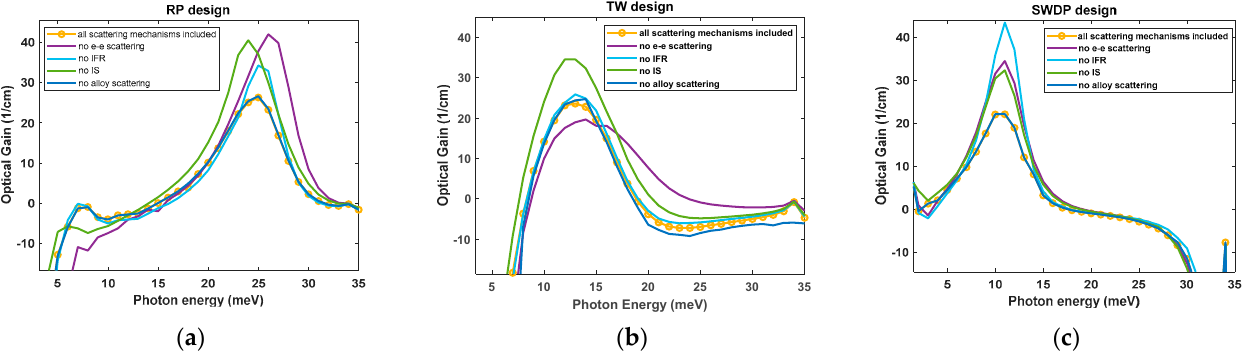
Figure 6. The contributions of the various scattering mechanisms to the optical gain for ( a ) RP, ( b ) TW, and ( c ) SWDP designs.